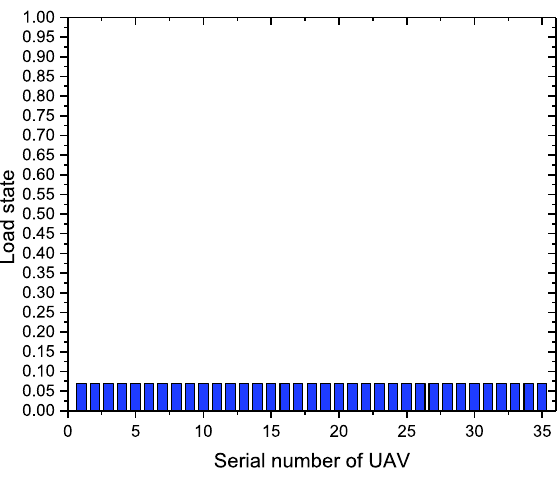
Figure 6. The initial load state of the UAV